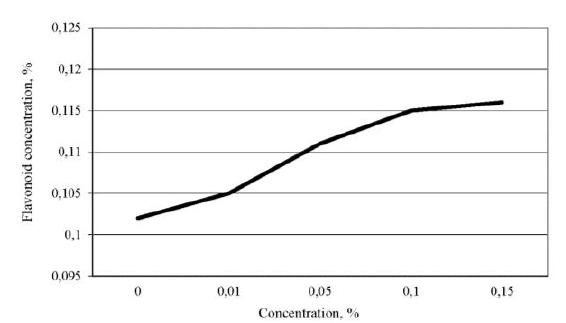
Fig. 10. Effect of polysorbate-80 on the amount of